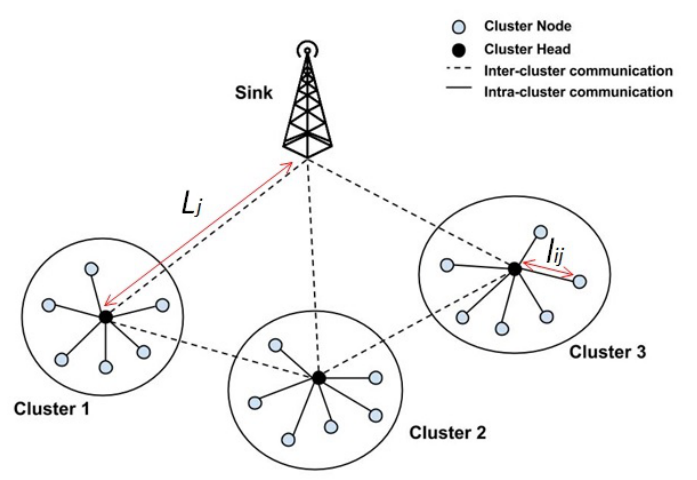
Figure 5. Network clustering scheme for cellular IoT